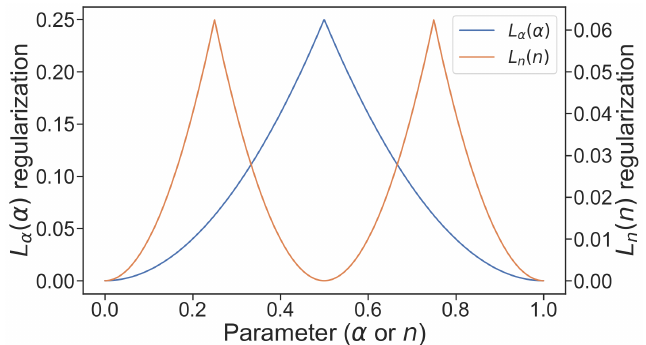
Figure 6. L-neuron-specific loss